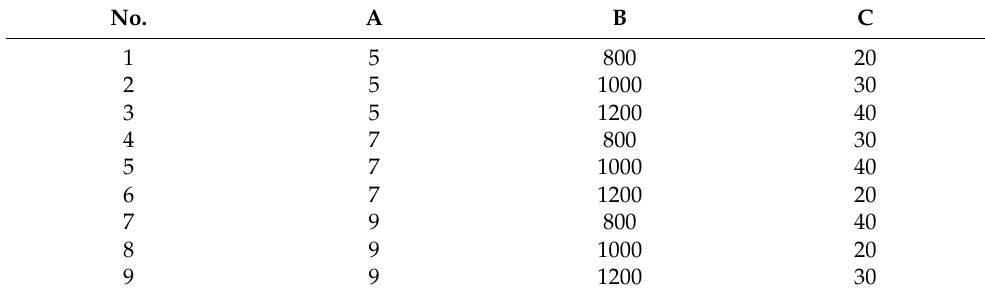
Table 4. Design of the L9 orthogonal experiment. No. A B